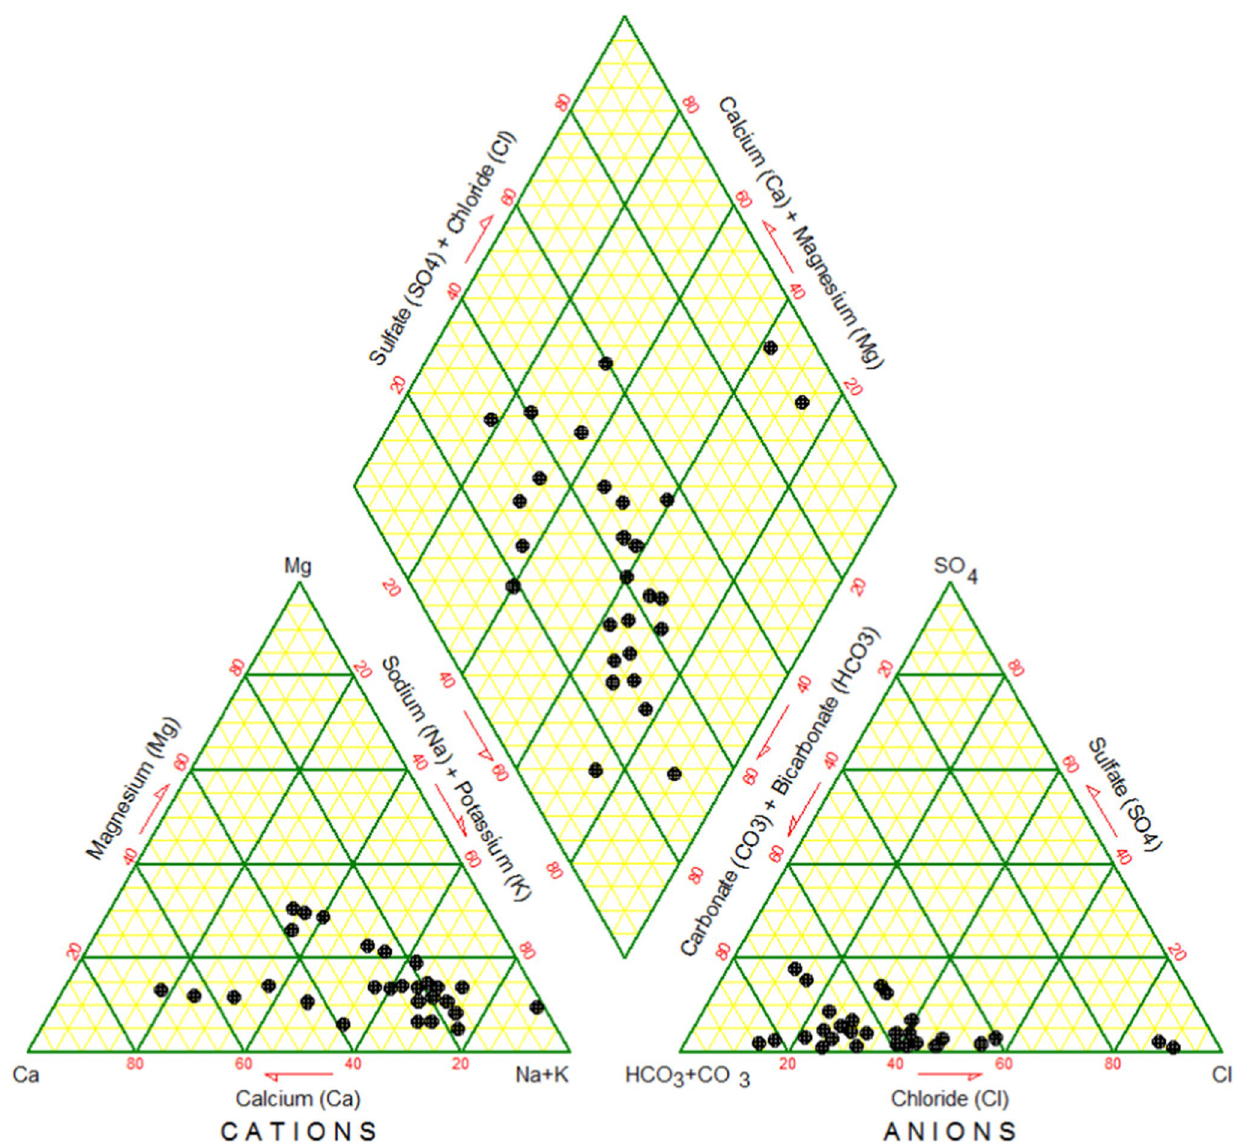
Fig. 2 Piper diagrams of groundwater samples from the Khaled-Abad